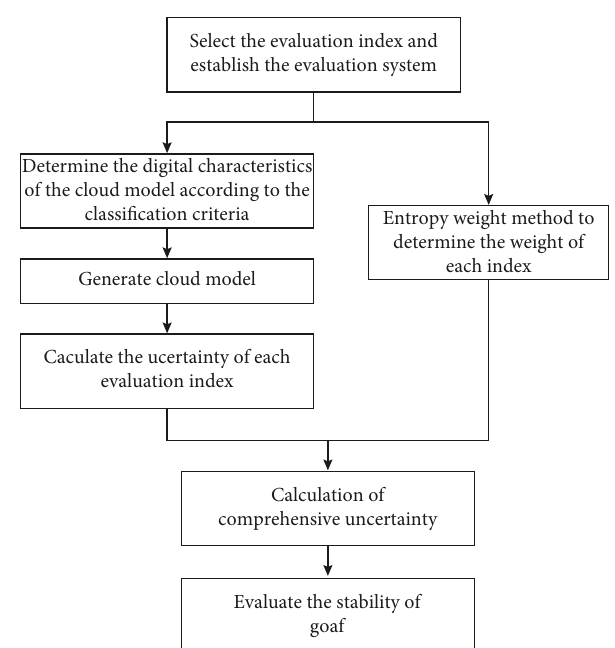
Figure 1: Stability evaluation process of